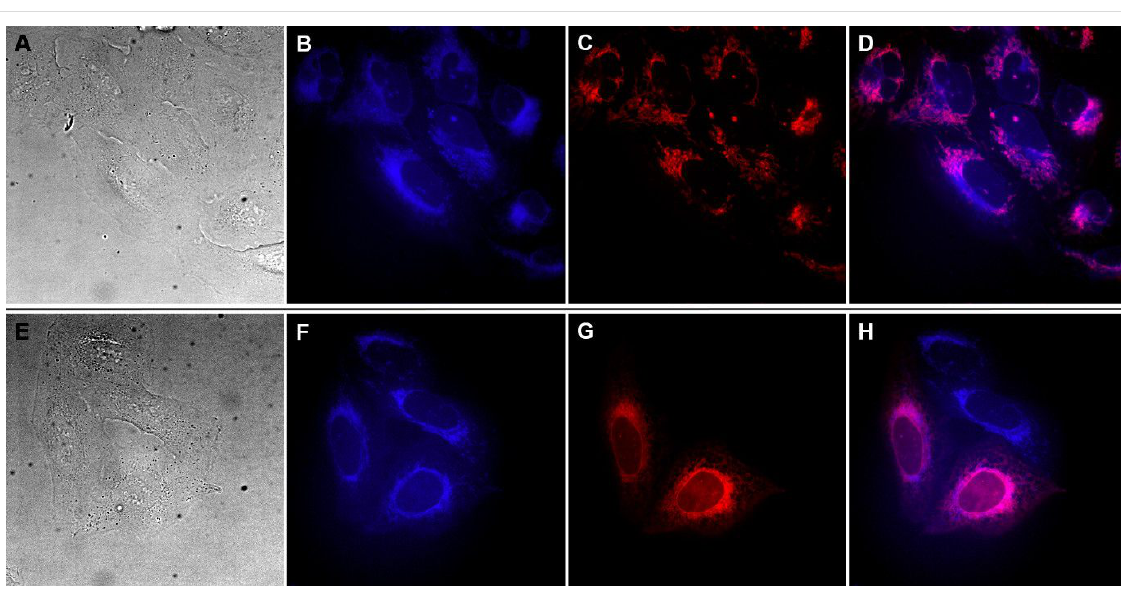
Figure 3: Co-localization of dansylarchangelolide 5 with a marker of endoplasmic reticulum (top row) and with a mitochondrial marker (bottom row) in human cells from osteosarcoma (U-2 OS). A, E) Bright-field images. Fluorescence microscopy of living cells treated with 1 µM concentration of com- pound 5 (90 min; images B and F) and a mitochondria-specific dye from [20] (10 min; image C) or pDNA coding mCherry-ER (image G). D, H) merged